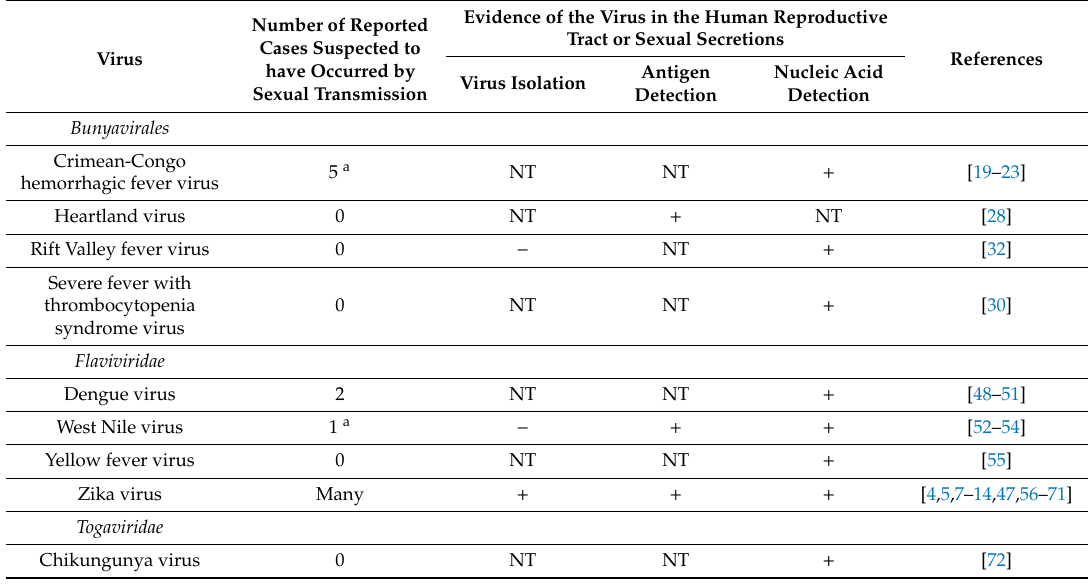
Table 1. Arboviruses with the potential to be sexually transmitted between humans as determined by apparentsexuallyacquiredcasesorthepresenceofthevirusinthereproductivetractorsexualsecretions.